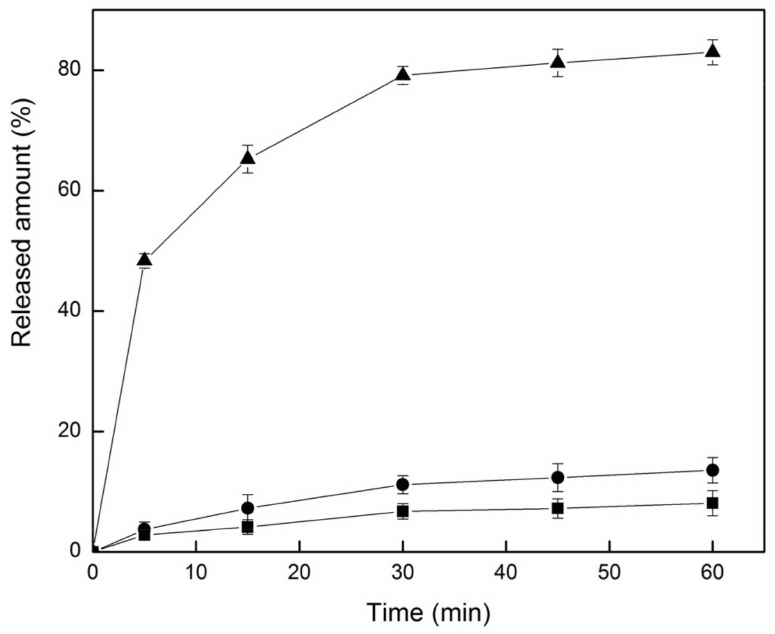
Figure 8. Dissolution profiles of G-Re ( (cid:4) ), G-Re- γ -CD PM ( • ), and G-Re- γ -CD IC ( (cid:78) ) in water. Each point represents the mean ± SD. (n =